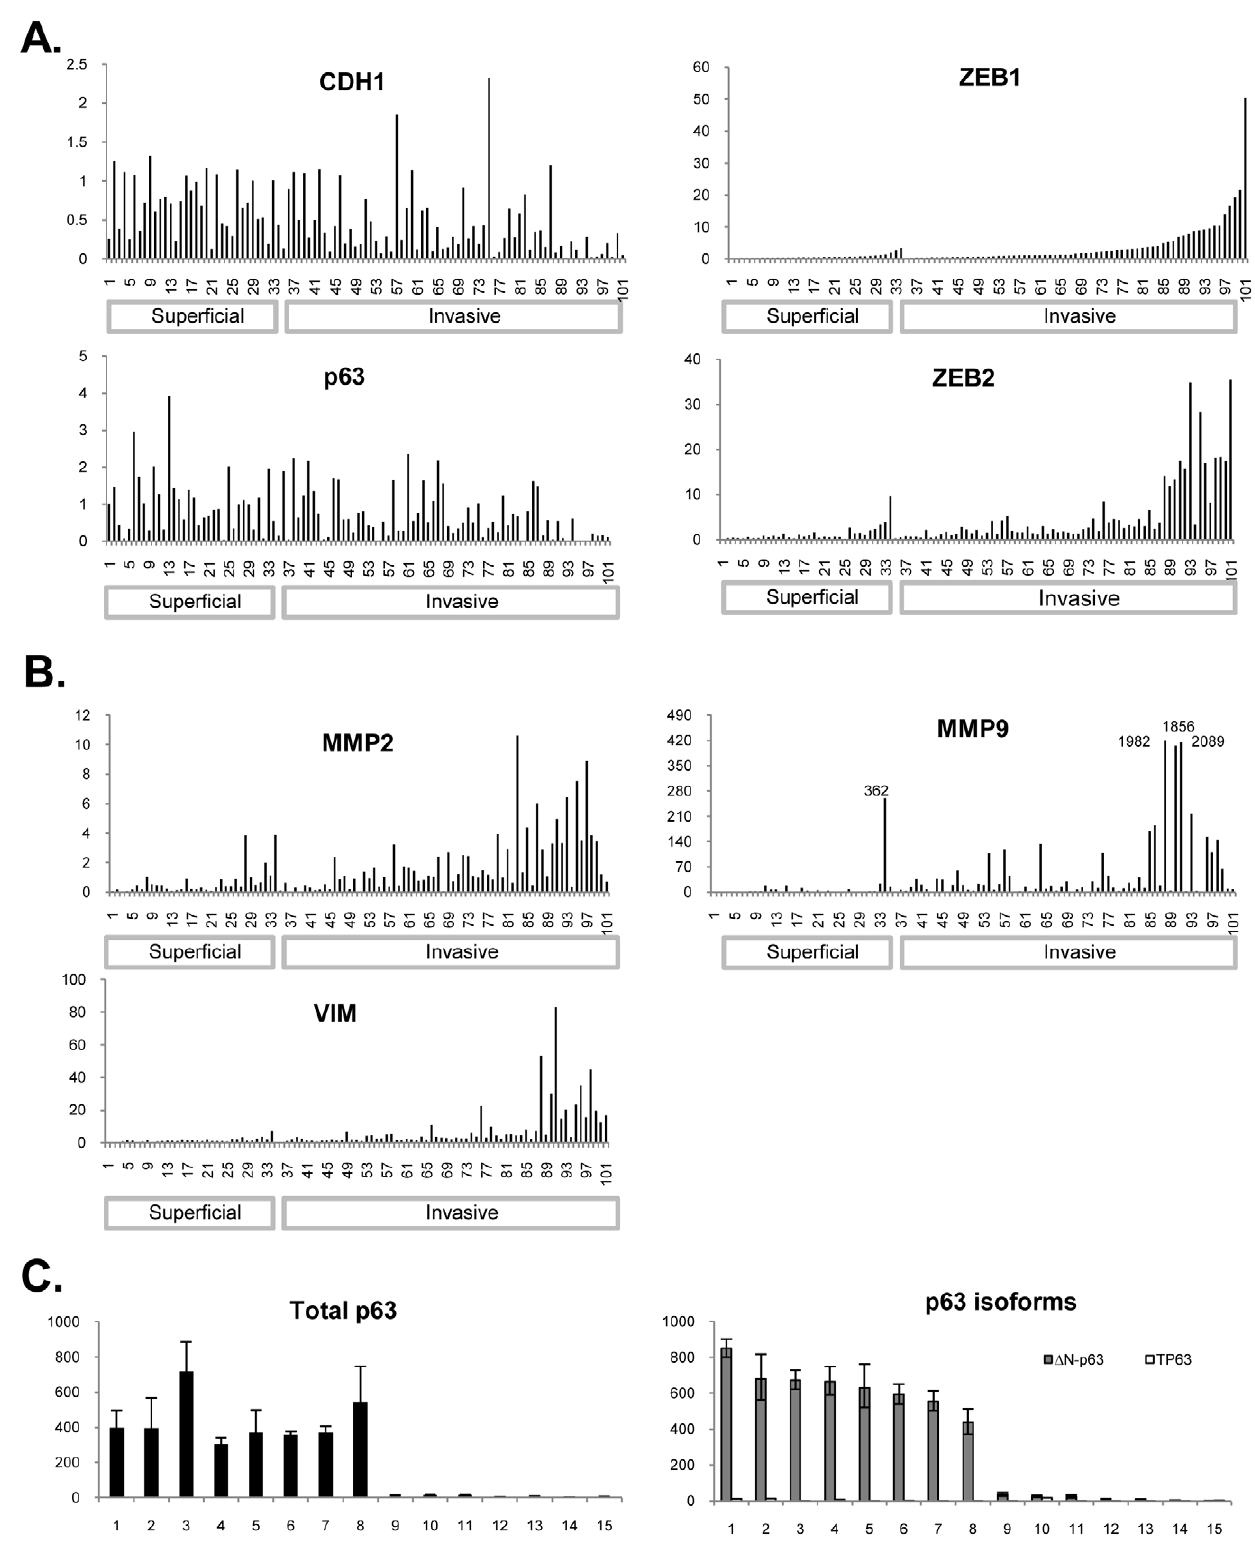
Figure 3. Expression of EMT markers in primary bladder tumors. (A) Expression of core E-cadherin-related EMT markers (E-cadherin, p63, Zeb-1, and Zeb-2) in 101 primary bladder tumors was assessed by quantitative real-time PCR. (B) Expression of MMP2, MMP9, and vimentin. (C) Expression of TAp63 and D N-p63 in a representative subset of the samples. All samples in each figure are shown in the same order.